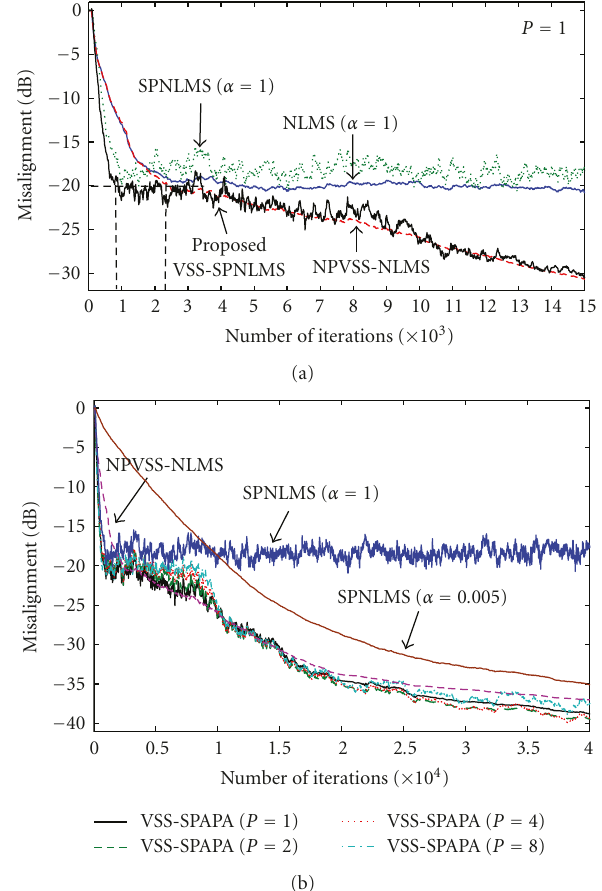
Figure 2: Misalignment of the algorithms with white Gaussian noise input. (a) P = 1. (b) Comparison of di ff erent projection order, P = 1, 2, 4, 8. SPNLMS and NPVSS-NLMS [21] are also